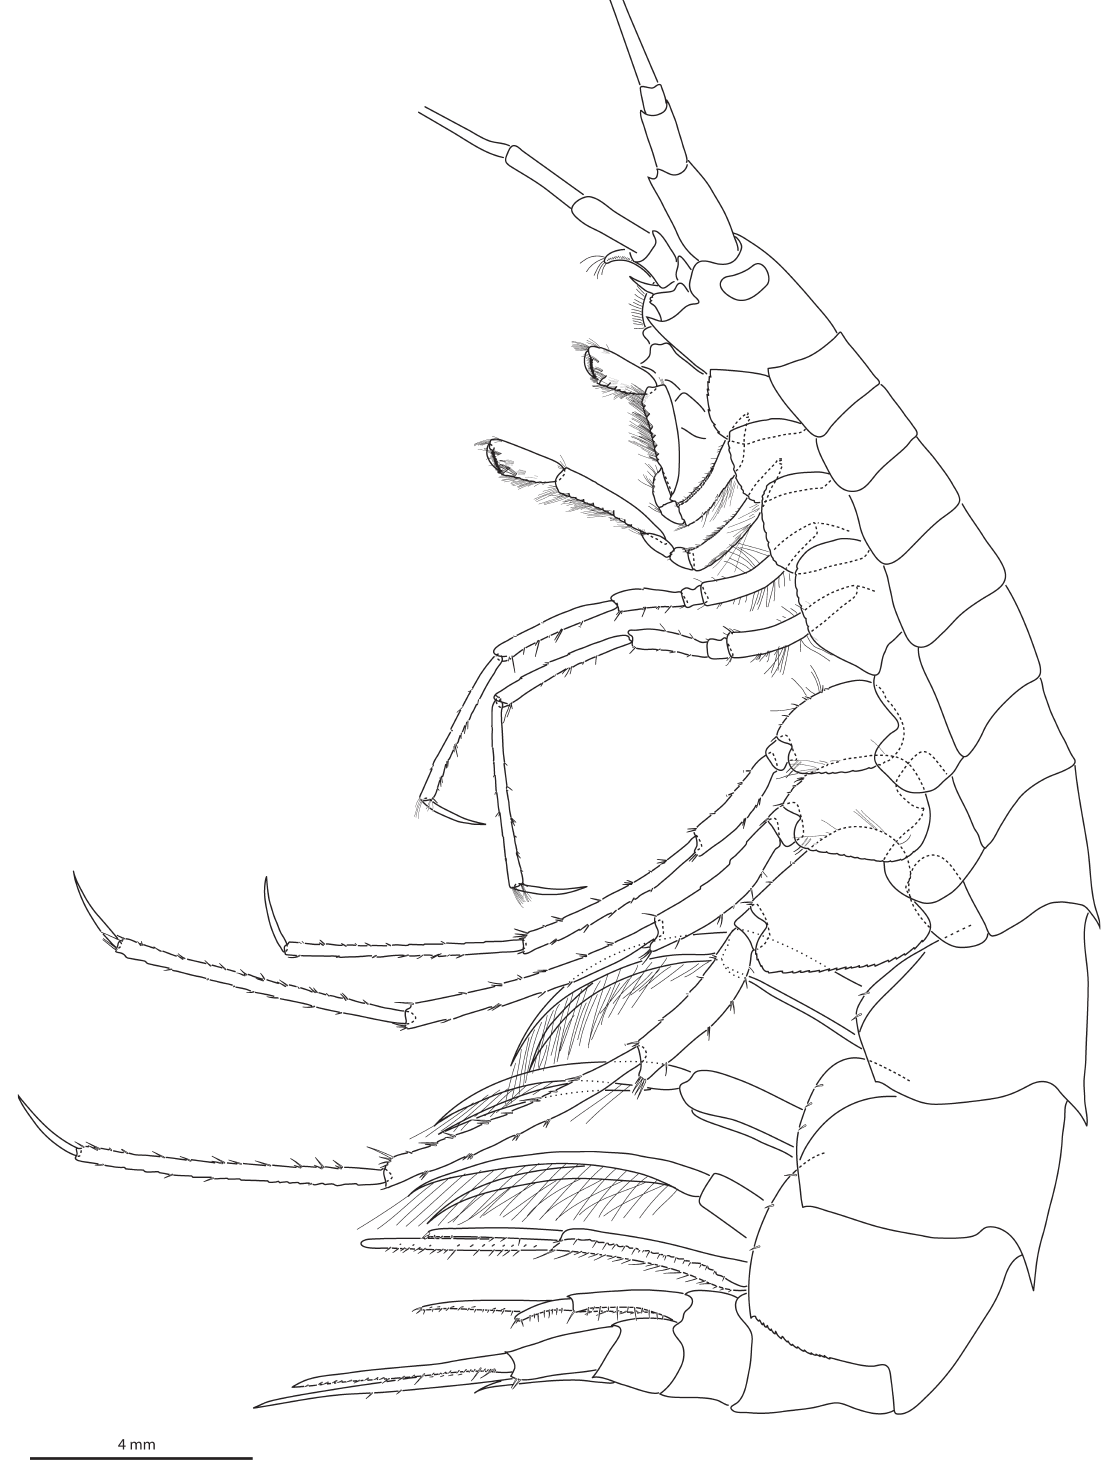
Fig. 2. Halirages cainae sp. nov., holotype ♂, 40 mm, Norwegian Sea, MAREANO 2009-111, R-station 487, sample 157, habitus, left side; pereiopods illustrated in leveled position; gnathopods (except coxae) illustrated after right